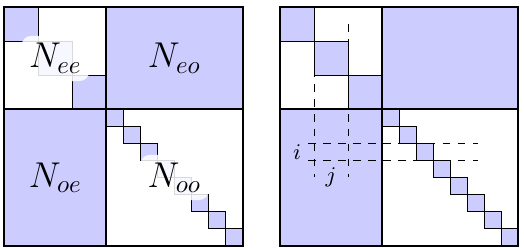
Figure 1: Non-zero structure of the normal matrix with the EO parameters first (left). The N ee block has 6-by-6 blocks that each correspond to the EO parameters of one camera. Similarly for N oo and object points, but with 3-by-3 blocks. The N oe block consists of 3-by-6 blocks that connect an image with an object point. Non-zeros can only appear at block row i , block column j of N eo if object point i was measured in image j (right).